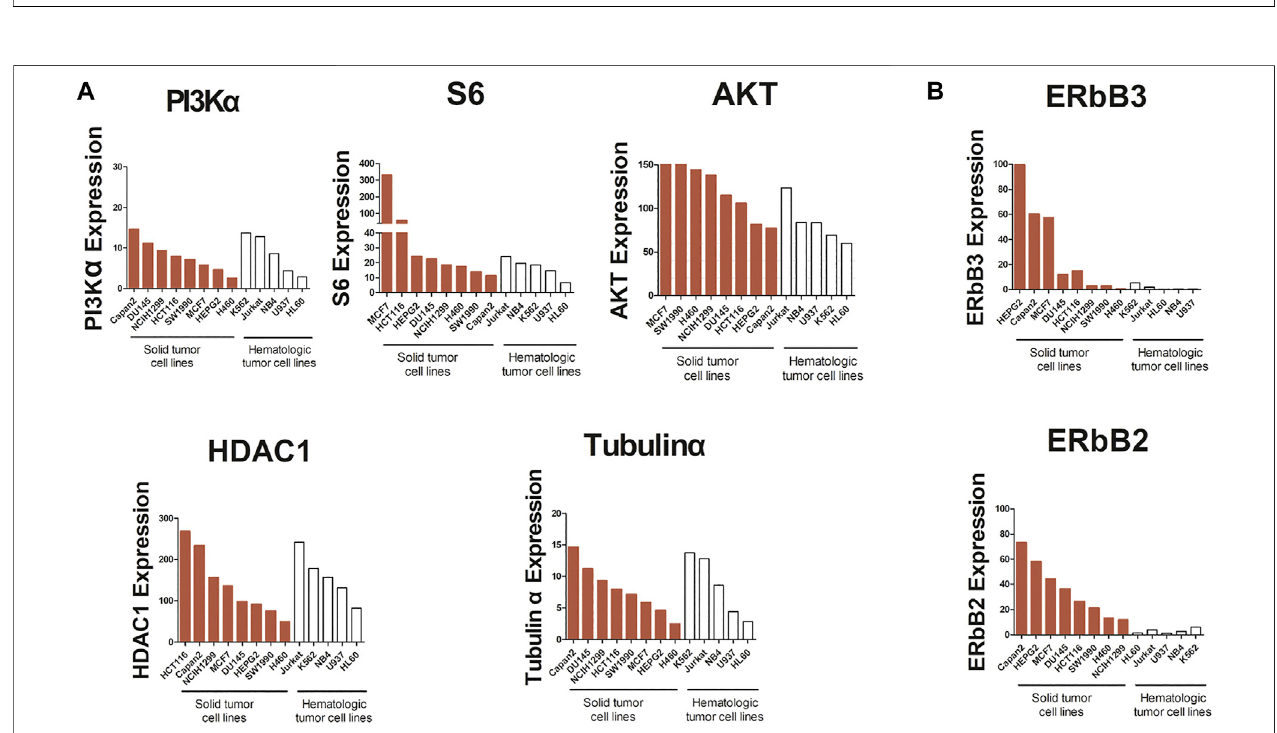
FIGURE 7 | Analysis of PI3K α , S6, AKT, HDAC1, Tubulin α , ERbB3, and ERbB2 mRNA expression in cancer cells. (A) The expression of PI3K α , S6, AKT, HDAC1 and Tubulin α in solid tumors and hematologic tumors at mRNA level. (B) The expression of ERbB2 and ERbB3 in solid tumors and hematologic tumors at mRNA level.